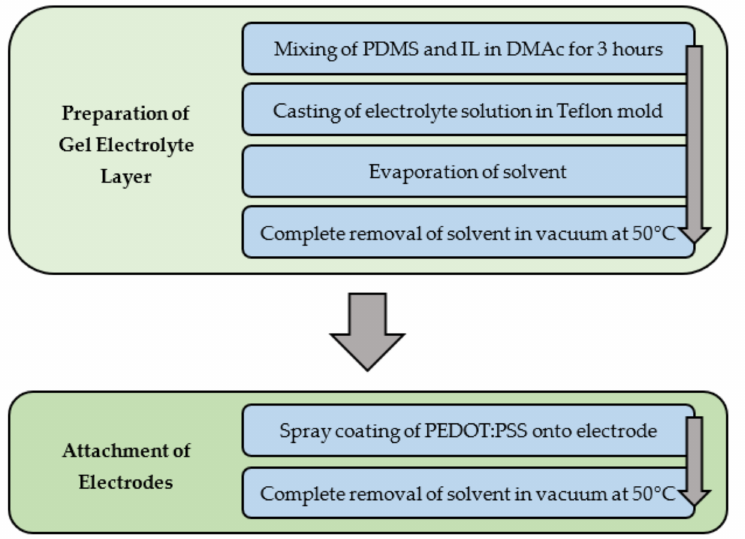
Figure 5. Synthesis of transparent ionic polymer gel EAP using PEDOT:PPS and IL of